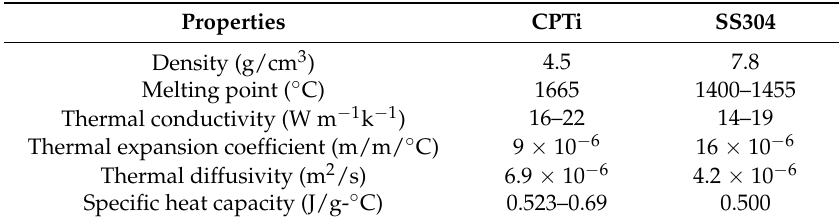
Table 3. Thermal properties of CPTi and SS304